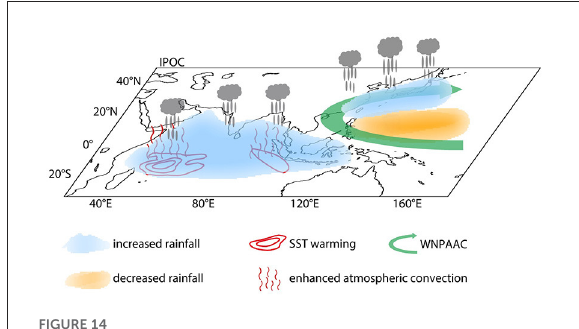
FIGURE14 Schematic representation of IPOC effect. Green arrow denotes the WNPAAC; red circles and vertical wavy lines denote SST warming and enhanced atmospheric convection, respectively; blue (yellow) shading as well as cloud symbols denote increased (decreased) rainfall there.